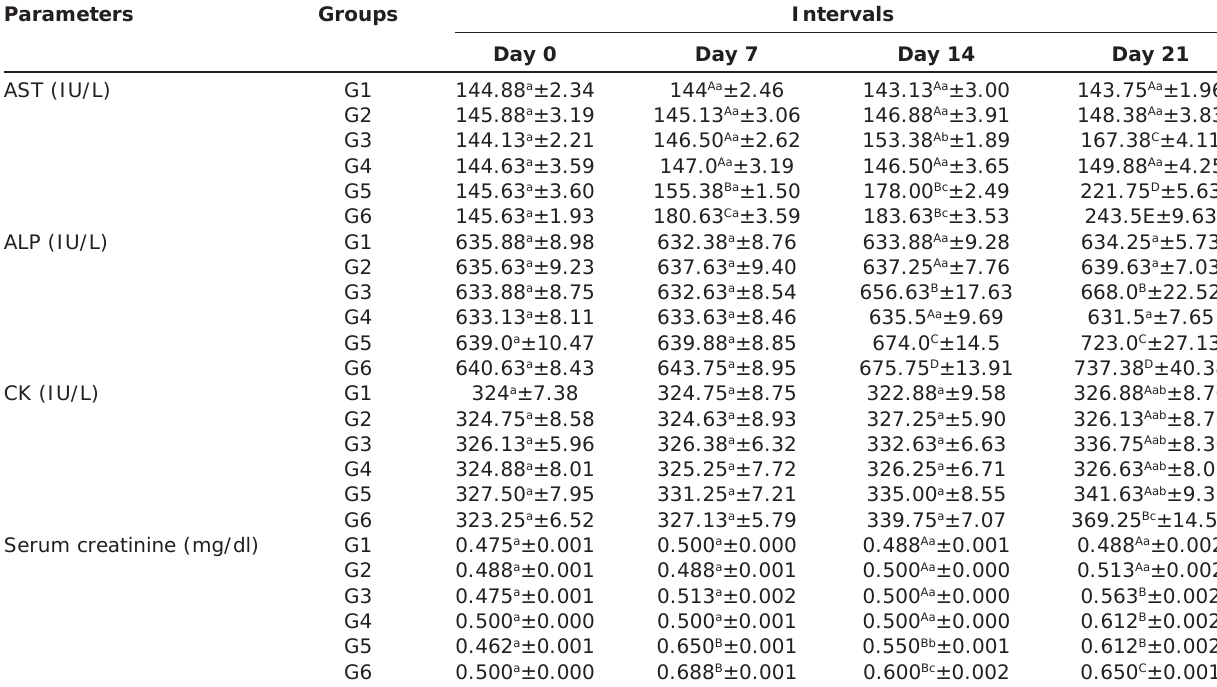
Table-2: Effect of F. tsiela Rox b extract and fresh juice on various biochemical parameters in adult female Sprague Dawley